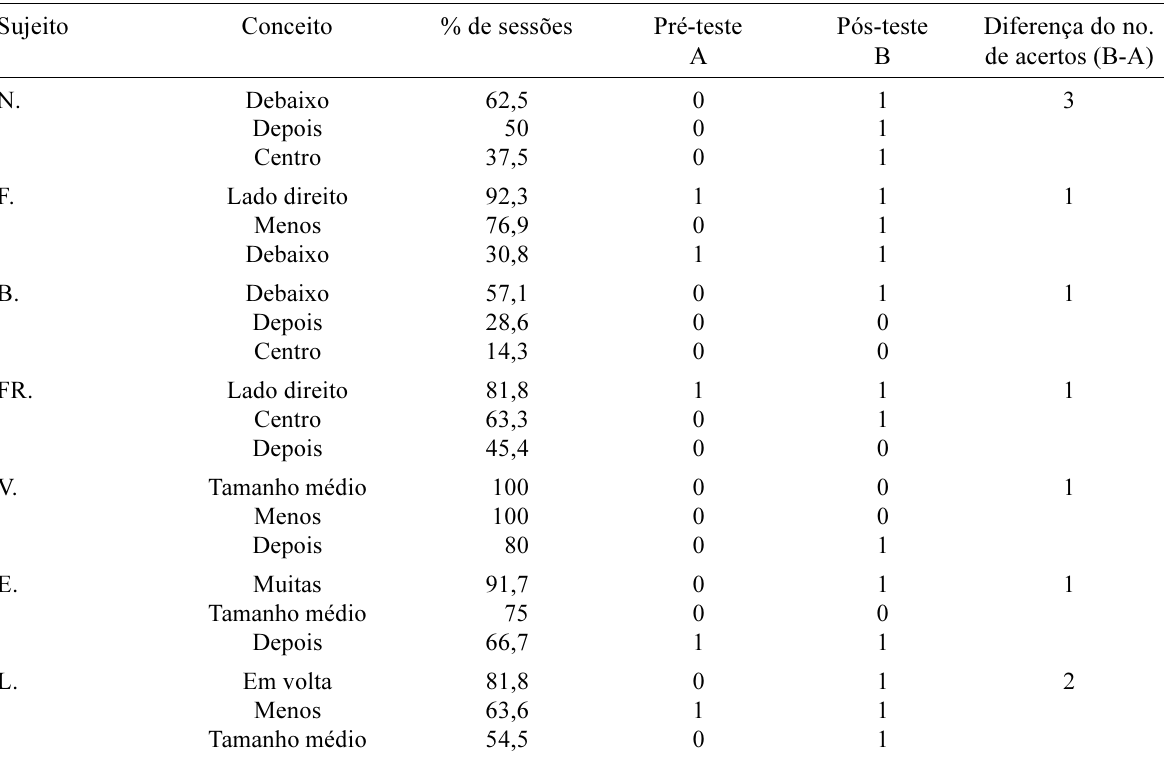
Conceitos Mais Vivenciados nas Sessões de Atividades Lúdicas, Respostas das Crianças no Pré-teste e no Pós-teste e Diferença do Número de Acertos